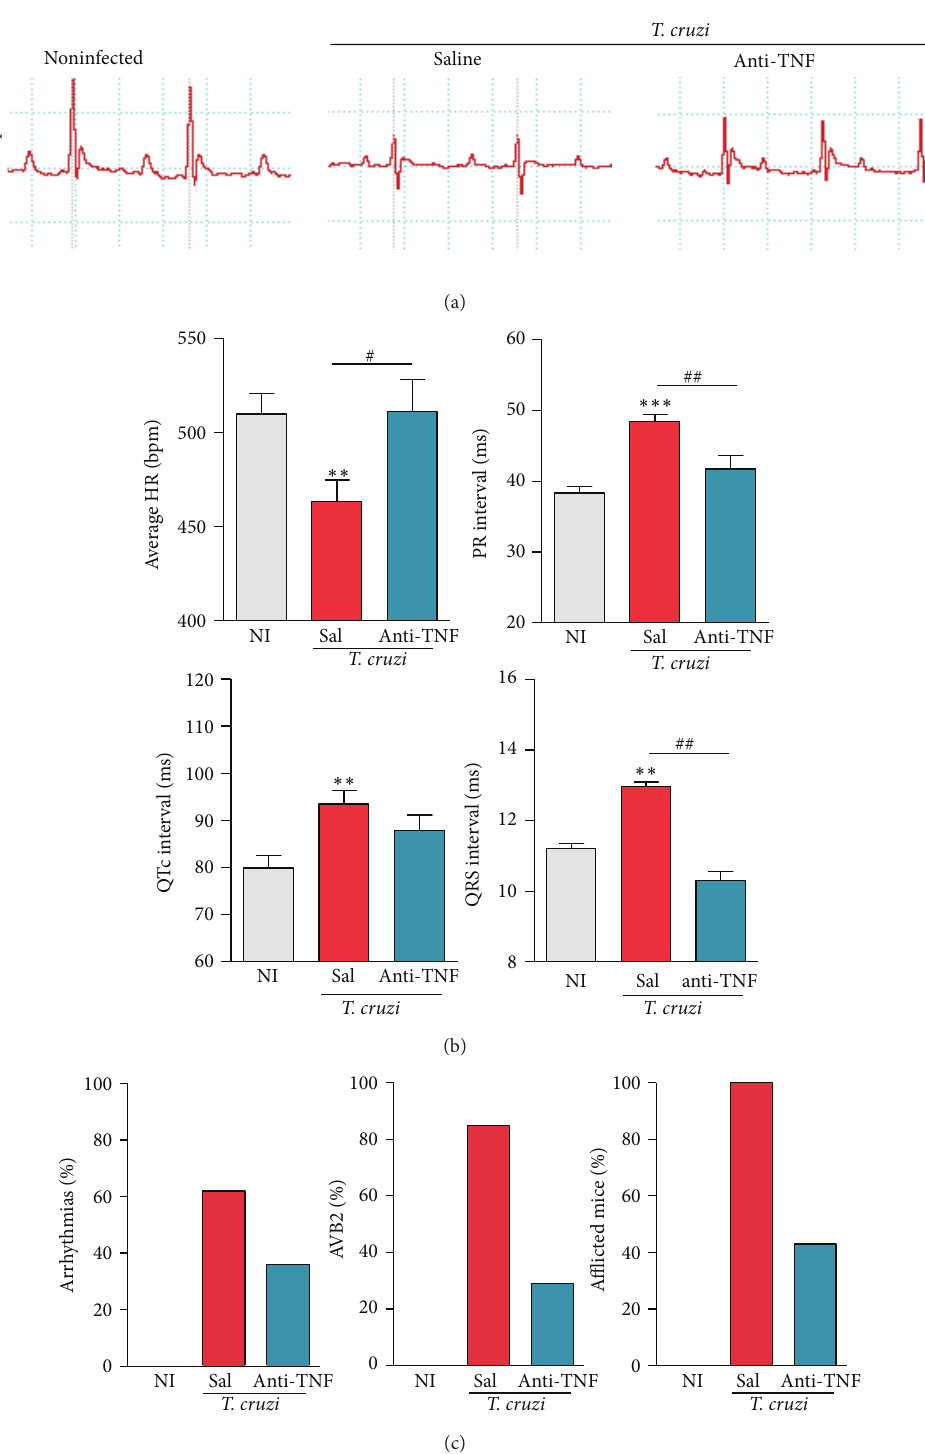
Figure7:Anti-TNFtherapyameliorateselectricalabnormalitiesinchronically Trypanosomacruzi -infectedmice.C57BL/6miceinfectedwith 100bt of the Colombian T. cruzi strain were treated from 120 to 150 dpi and analyzed at 150 dpi. (a) Representative ECG register segments of sex- and age-matched NI controls and T. cruzi -infected mice injected with saline or anti-TNF, at 150 dpi. (b) Group data for the ECG records showing the heart rate (beats per minute, bpm), variation in the PR, QTc, and QRS intervals. (c) Summary of the group data from NI and T. cruzi -infected mice (injected with saline or anti-TNF) showing the frequency of mice presenting ART, AVB2 and afflicted by any ECG alterations. ∗∗ 𝑃 < 0.01 and ∗∗∗ 𝑃 < 0.001 , T. cruzi -infected mice (saline injected or anti-TNF treated) compared to NI controls. # 𝑃 < 0.05 and ## 𝑃 < 0.01 , anti-TNF-treated compared to saline-injected T. cruzi -infected mice. Bar represents the mean ± SD of the studied group (10 to 15 mice). These data represent three independent